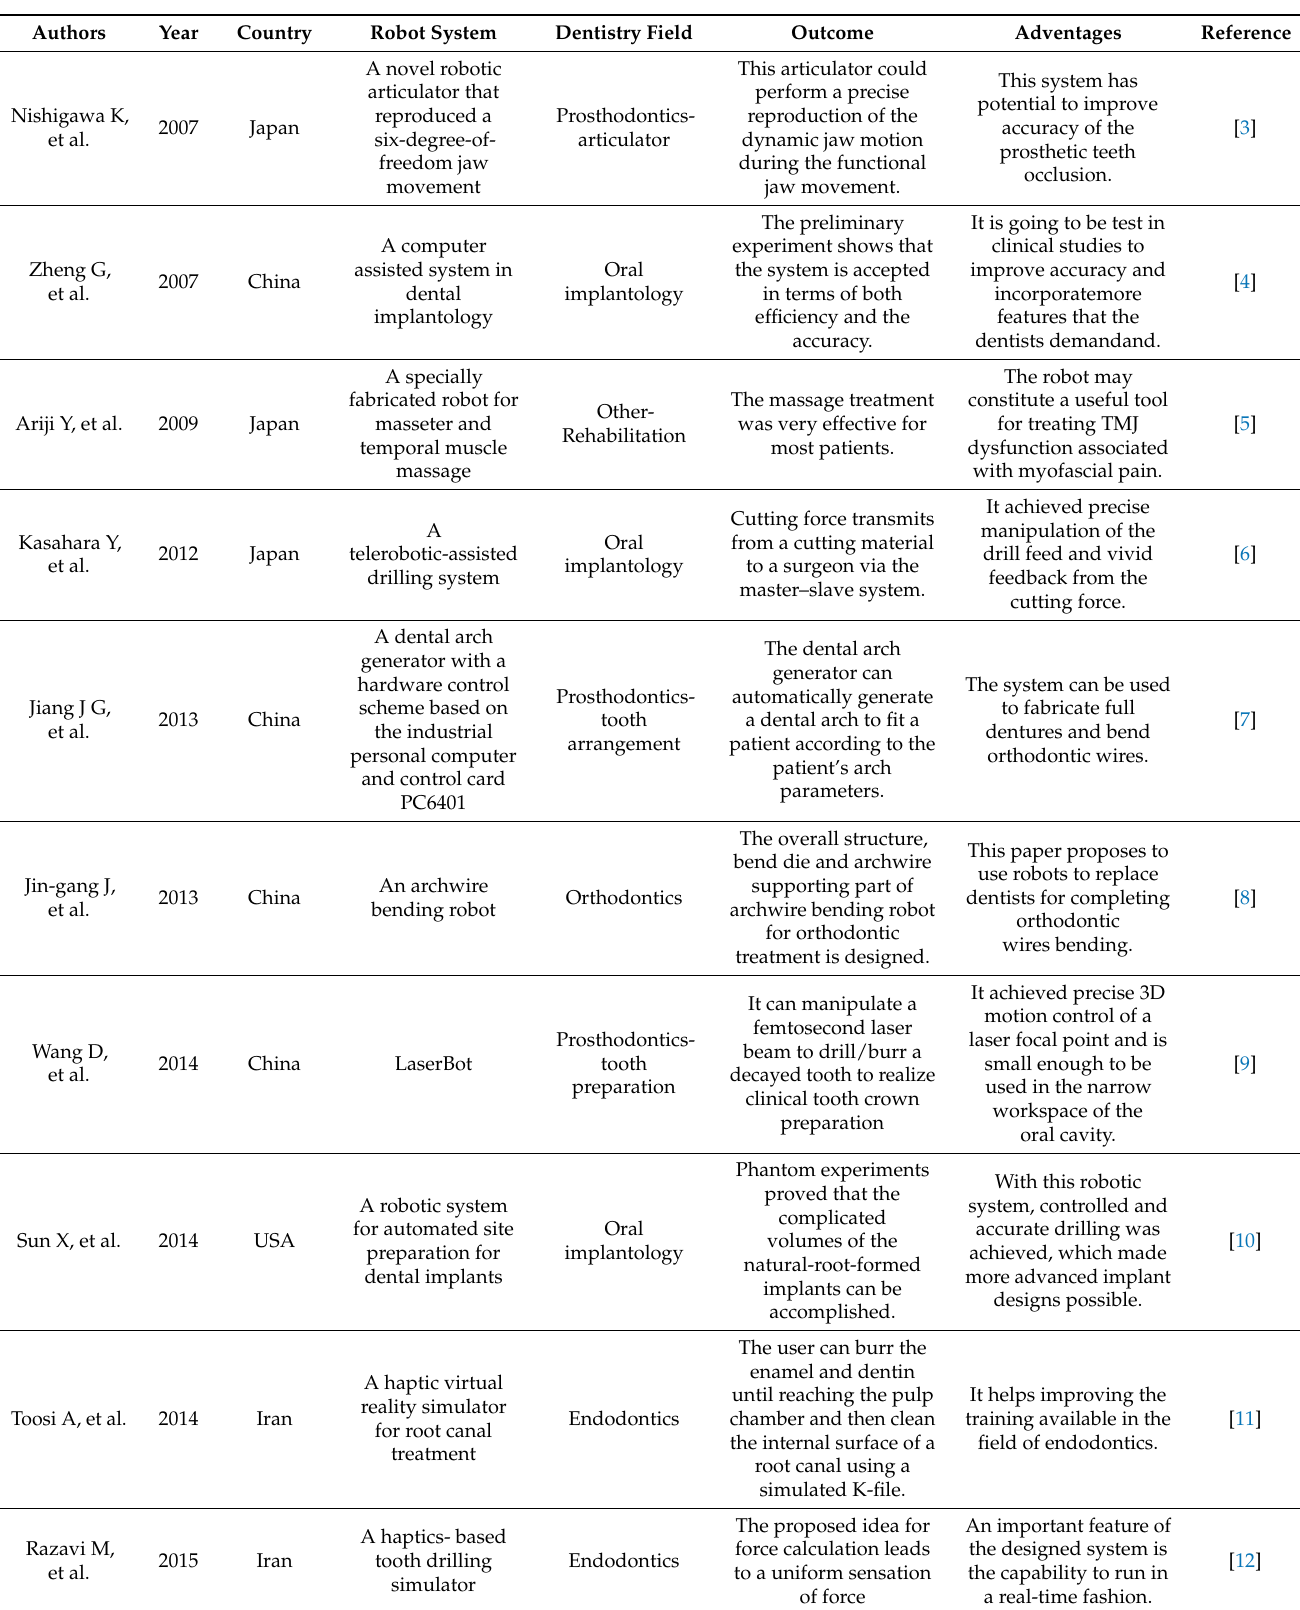
Table 1. The characteristics of the representative articles in different dentistry